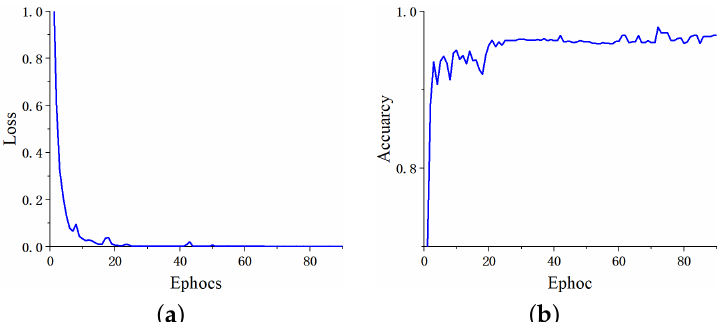
Figure 13. The curves of the training process on dataset BT-3C. ( a ) Training loss, ( b ) validation accuracy.